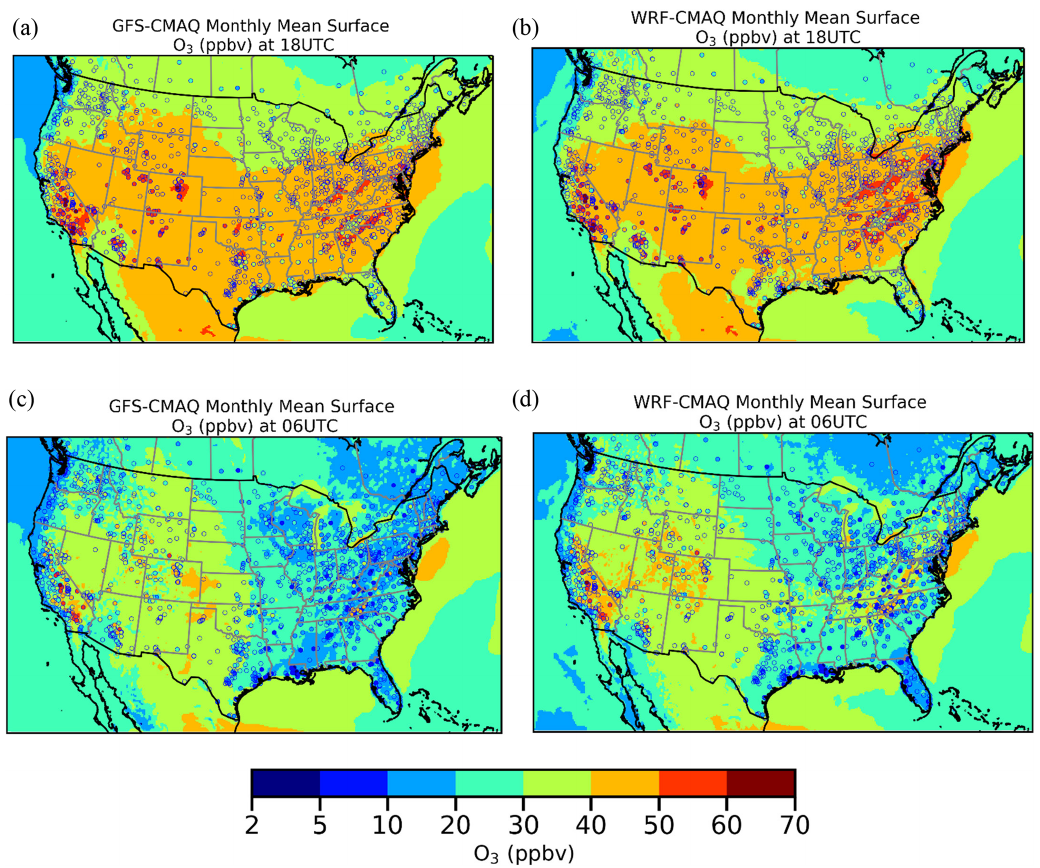
Figure 5. Monthly mean surface O 3 predictions by GFS-CMAQ (a, c) and WRF-CMAQ (b, d) for daytime (a, b) and nighttime (c, d) compared with the corresponding AIRNow observations for August